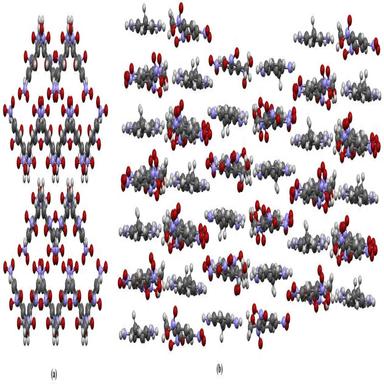
(a) A comparison of the herringbone packing of TNT , (b) the face-to-face P-stacking of the TNTeATL co-crystal.